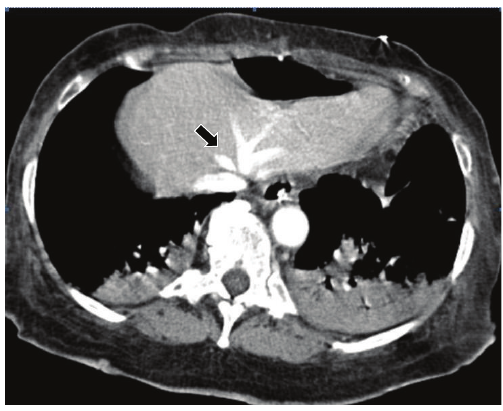
Figure 4: CT image of the liver shows normal contrast enhance- ment of hepatic venous system ( arrow ). It also shows bibasilar